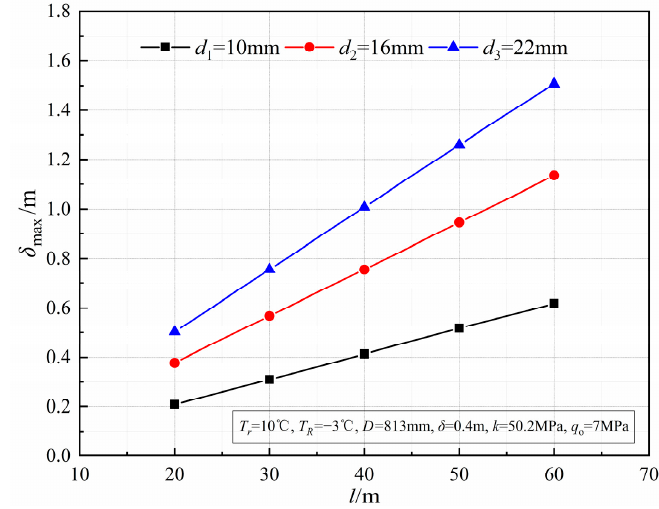
Figure 10. Effect of transition length on maximum allowable frost heave deformation.